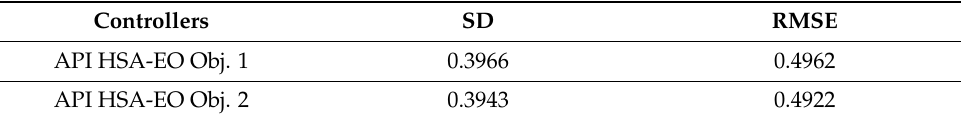
Table 12. Statistical analysis of the active power—faulty first case.